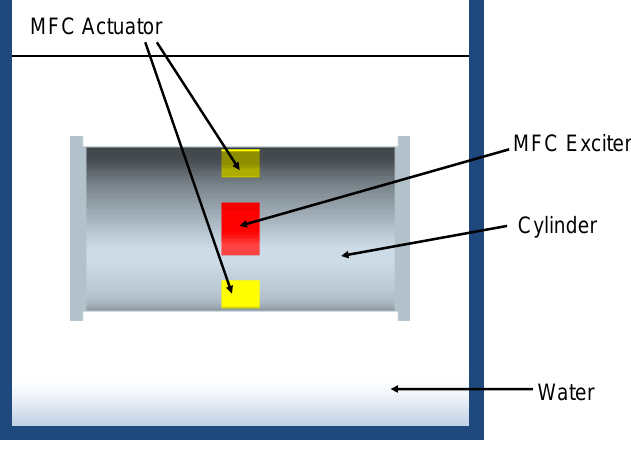
Figure 1. Schematic diagram of the proposed underwater cylindrical shell